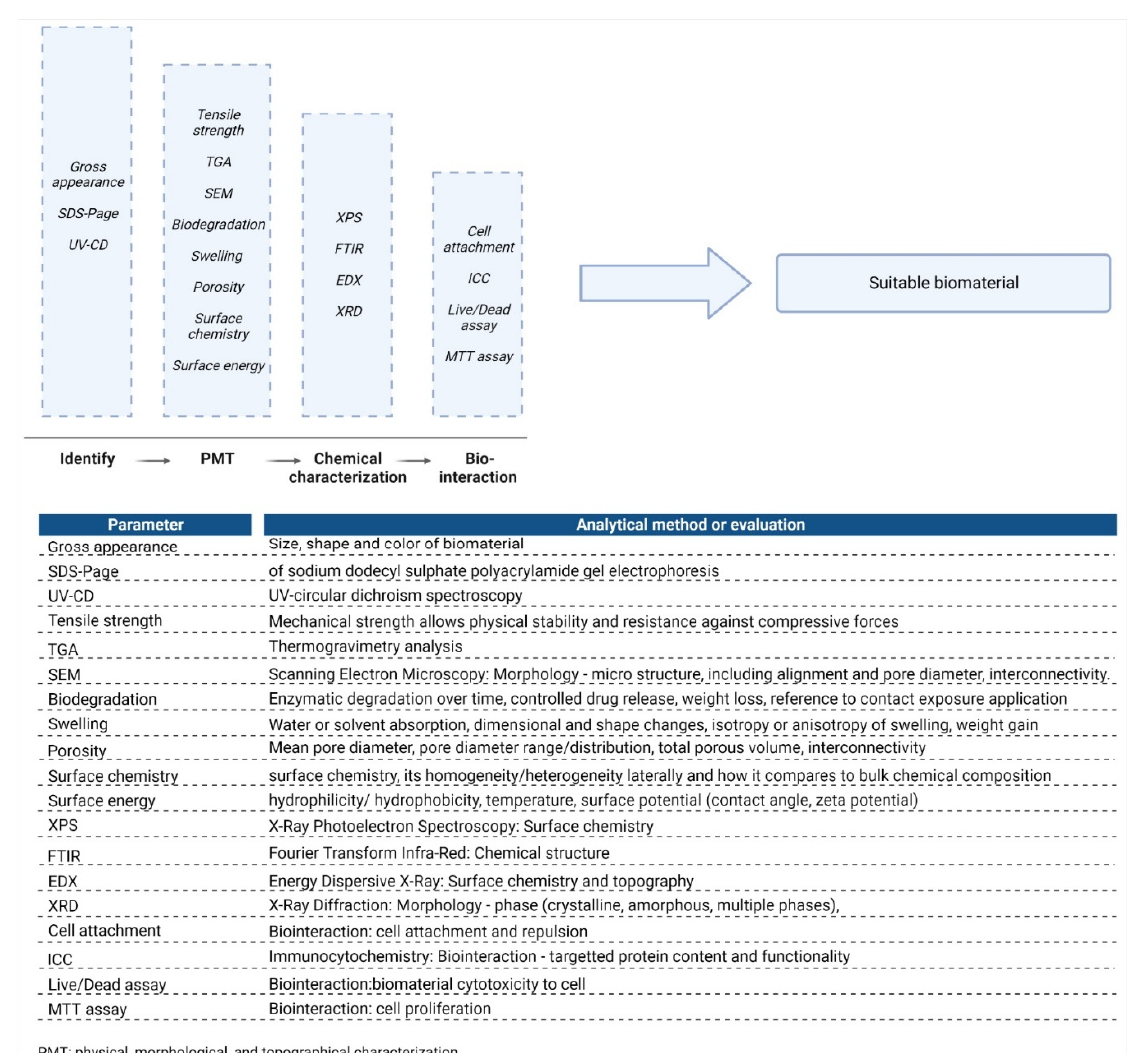
Figure 4. Parametric selection for the most suitable biomaterial.